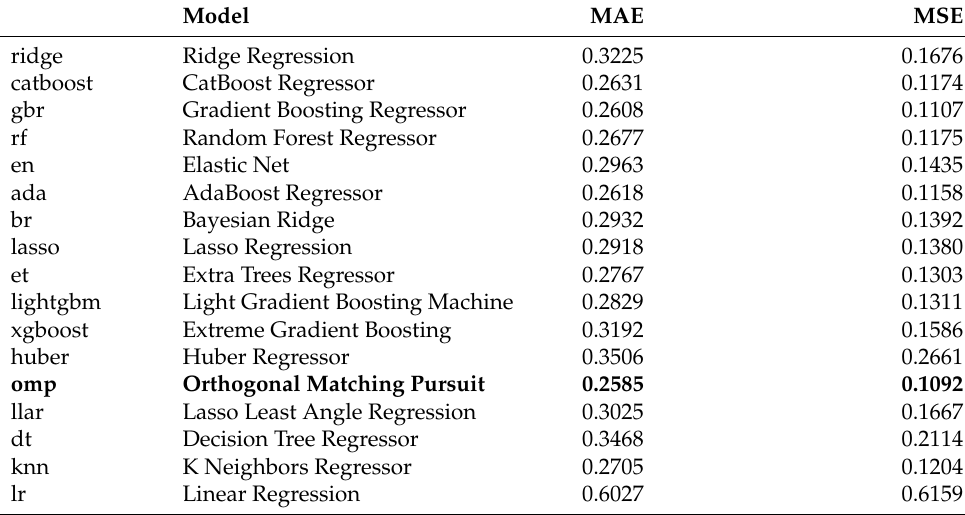
Table 2. Cross-validation scores including MAE and MSE metrics.